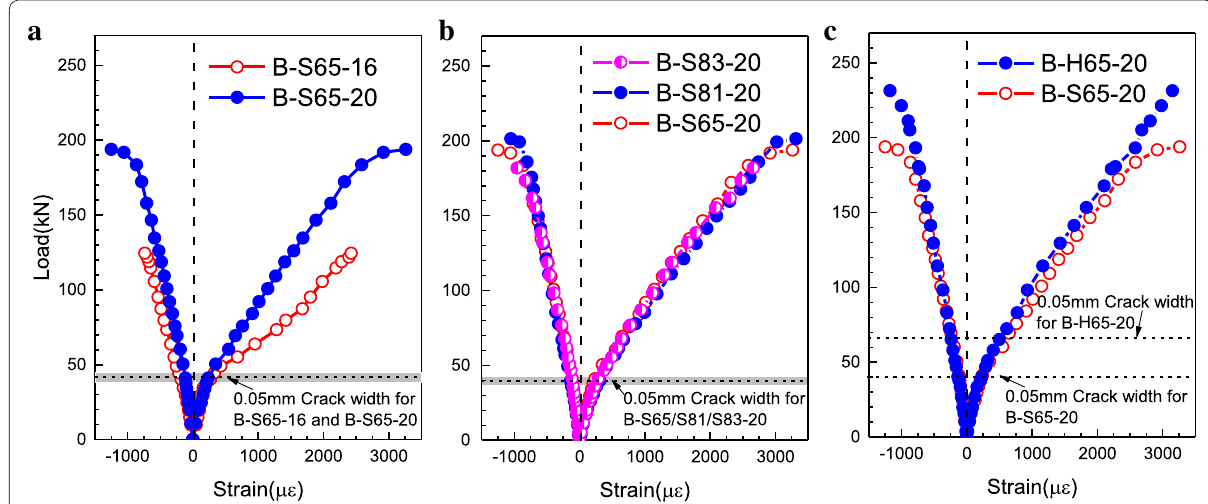
Fig. 12 Load versus top and bottom surface concrete strains of pure bending regions: ( a ) different reinforcement ratios; ( b ) different fiber lengths; ( c ) different fiber